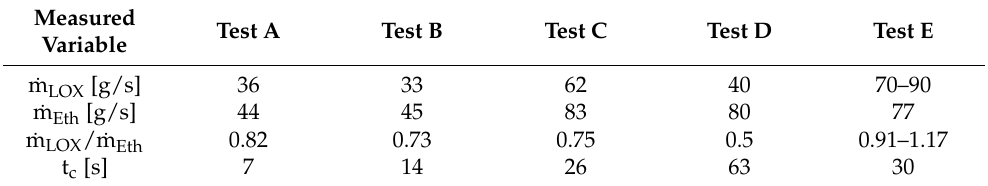
Figure 21. Comparison photos of the flame tube before the hot tests were carried out ( left ) and thereafter ( right ). Table 3. Averaged measurement data recorded during testing of the flame